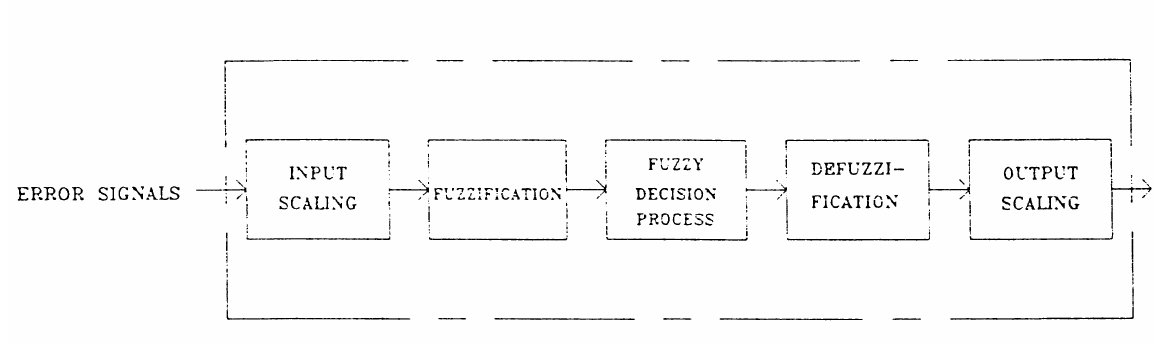
FIGURE 7 Basic architecture of a fuzzy logic